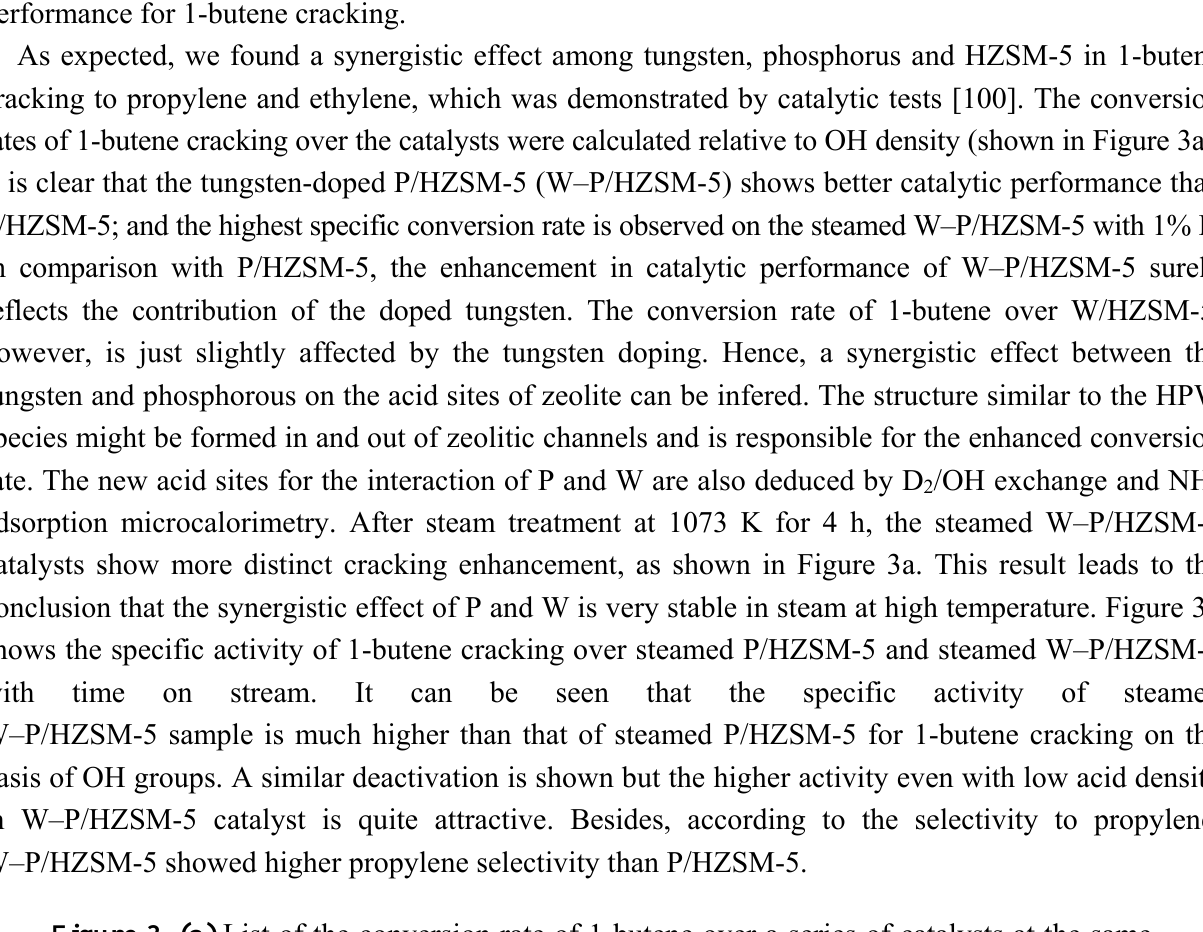
Figure 3. (a) List of the conversion rate of 1-butene over a series of catalysts at the same reaction conditions; (b) relative catalytic performance of steamed P/HZSM-5 (containing 1%P) and steamed W–P/HZSM-5 (containing 1%P) samples as a function of time on stream /1-butene = 3). Adapted from Reference (temperature: 803 K; WHSV = 13 h -1 ; N 2